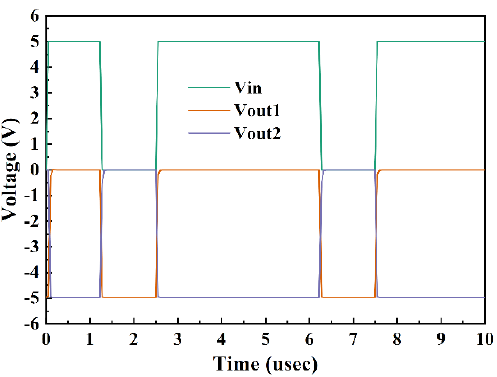
Figure 15. The time domain transient simulation results of the logic control circuit.